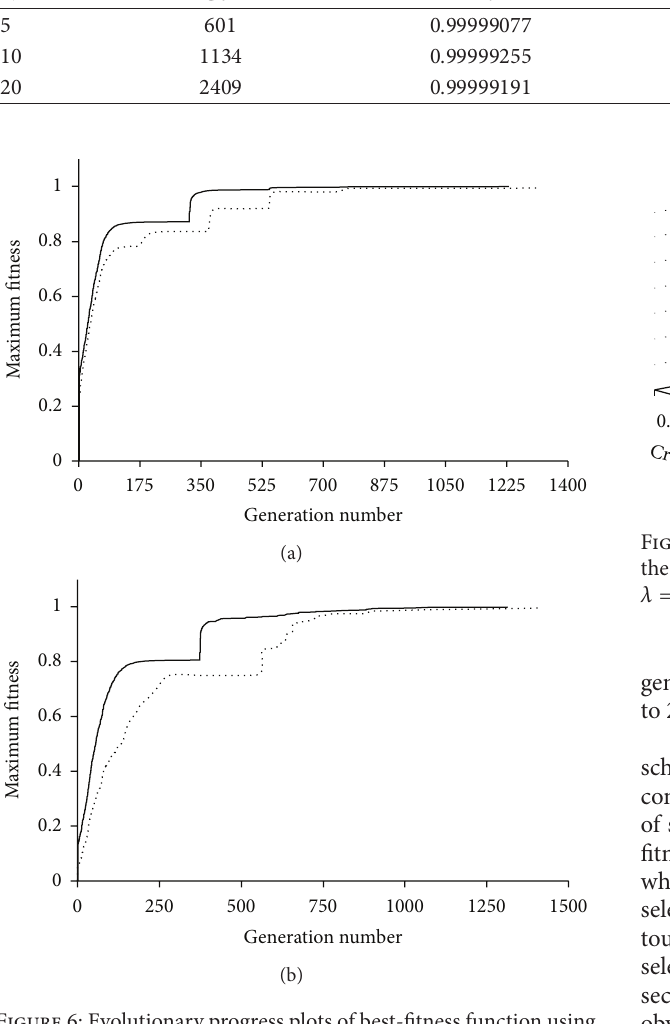
Figure 6: Evolutionary progress plots of best-fitness function using (. ..) and 𝐿 ( — ) vector norms for (a) Troesch’s problem, when 𝐿 1 : 2 : 𝜆 = 1 , and (b) Bratu’s problem, when 𝜇 = 2 .